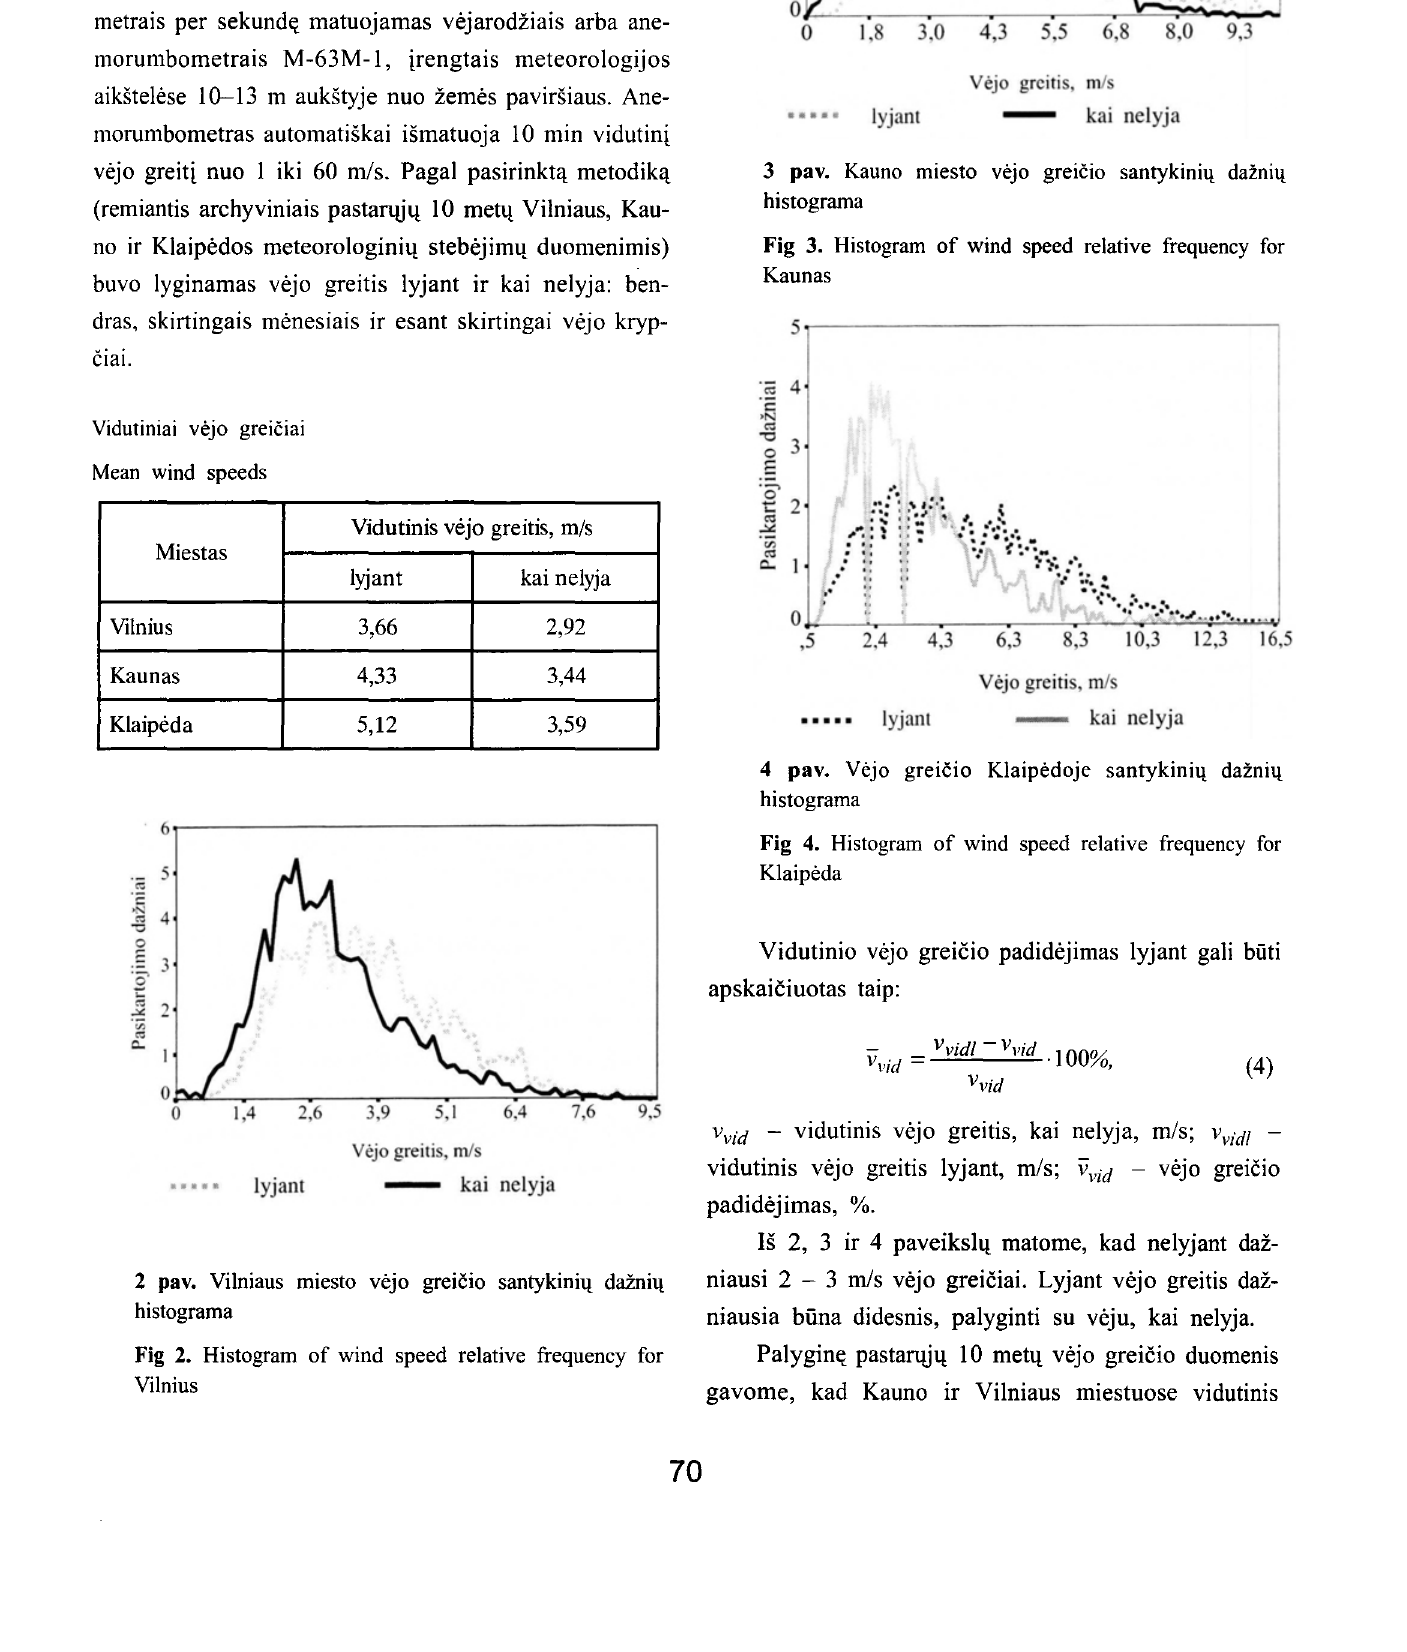
Fig 2. Histogram of wind speed relative frequency for Vilnius